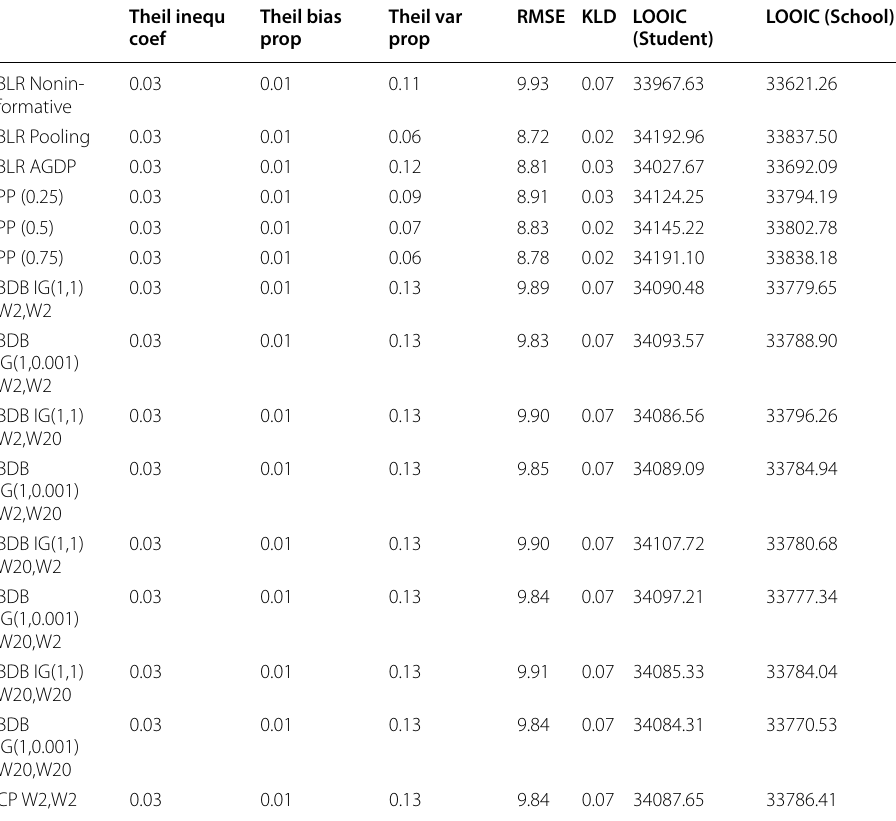
Table 3 Prediction performance of different borrowing methods for the sample of female students in high poverty